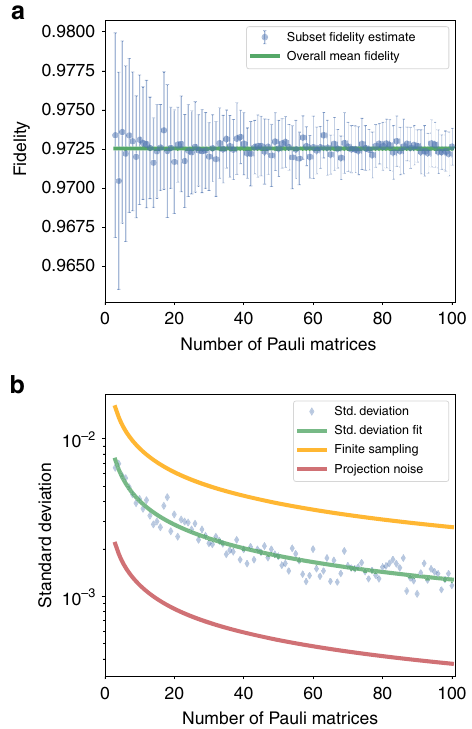
Fig. 2 Experimental evidence demonstrating rapid convergence under fi nite sample size with favorable constant factors. a Mean fi delity estimates from 30 randomly sampled subsets of Pauli matrices as a function of the size K of the subset. The error bars illustrate the standard deviation of the 30 samples, that is, the standard error of the mean. The green line describes the mean fi delity F ¼ 97 : 25 ð 8 Þ % calculated from the complete data set. b The standard deviation of the fi delity from plot a against K including a bound due to fi nite sampling of Pauli channels σ ffiffiffi p K 0 : 0275 ð 8 Þ = in orange, a fi t of the standard deviation σ ¼ 0 : 0127 ð 2 Þ = in green, and a fi t of the expected projection noise σ in red (see Supplementary Note